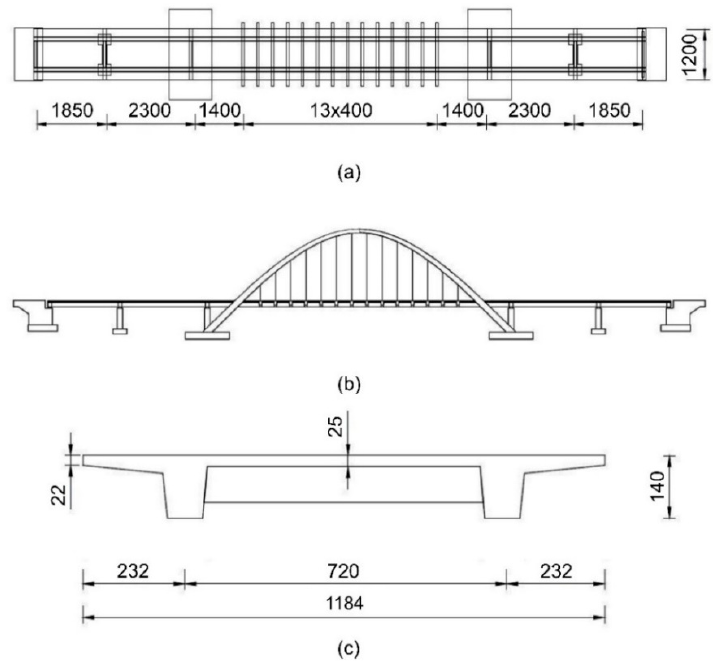
Figure 8. The main dimensions of the viaduct (cm): ( a ) top view; ( b ) side view; ( c )